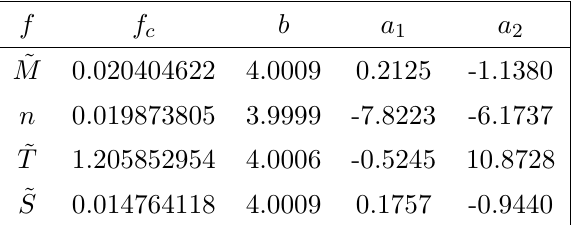
Q b ( a 1 + a 2 log Q ) where f stands for di(cid:11)erent (cid:0)